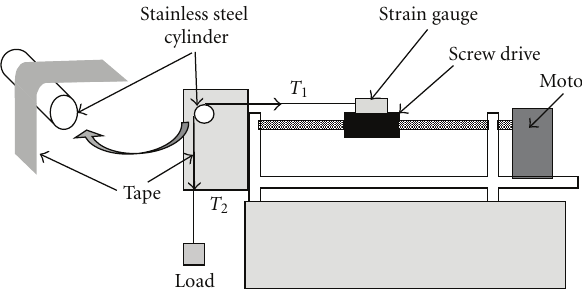
Figure 4: Schematic diagram of the friction measurement appara- tus for ME tapes.